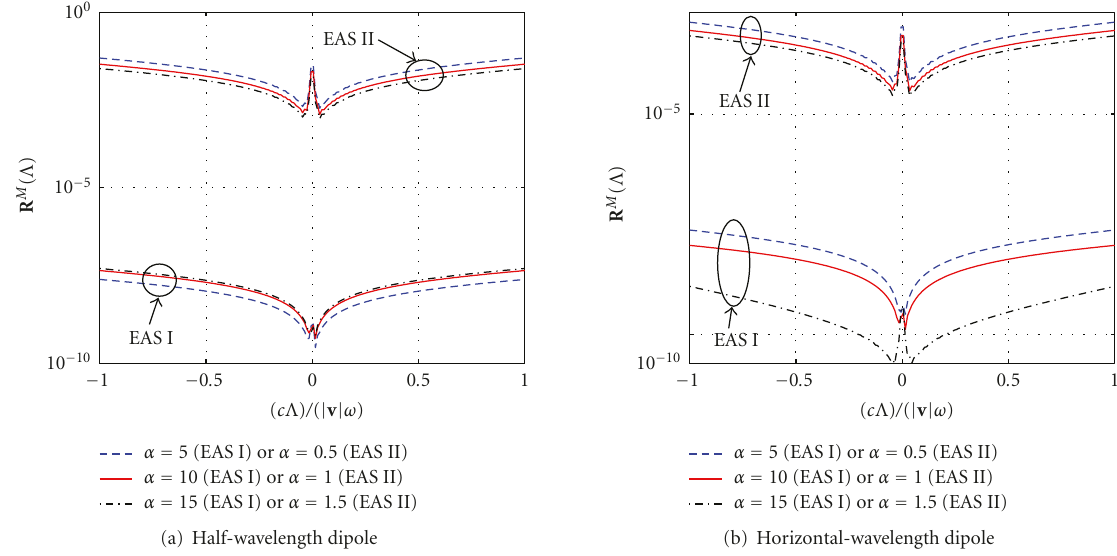
Figure 5: Power spectral density (PSD) for 3D propagation when MS moves on the positive direction of the y -axis , for stationary CCF ( ω 1 = ω 2 = ω , κ 2 = 0, and m = n = 1), | v | = 50Km/h, for two nonisotropic EAS pdfs (EAS I and EAS II pdfs), and nonisotropic AAS (Laplacian pdf with a = 0 . 25). (a) Half-wavelength dipole, (b) horizontal-electric dipole.